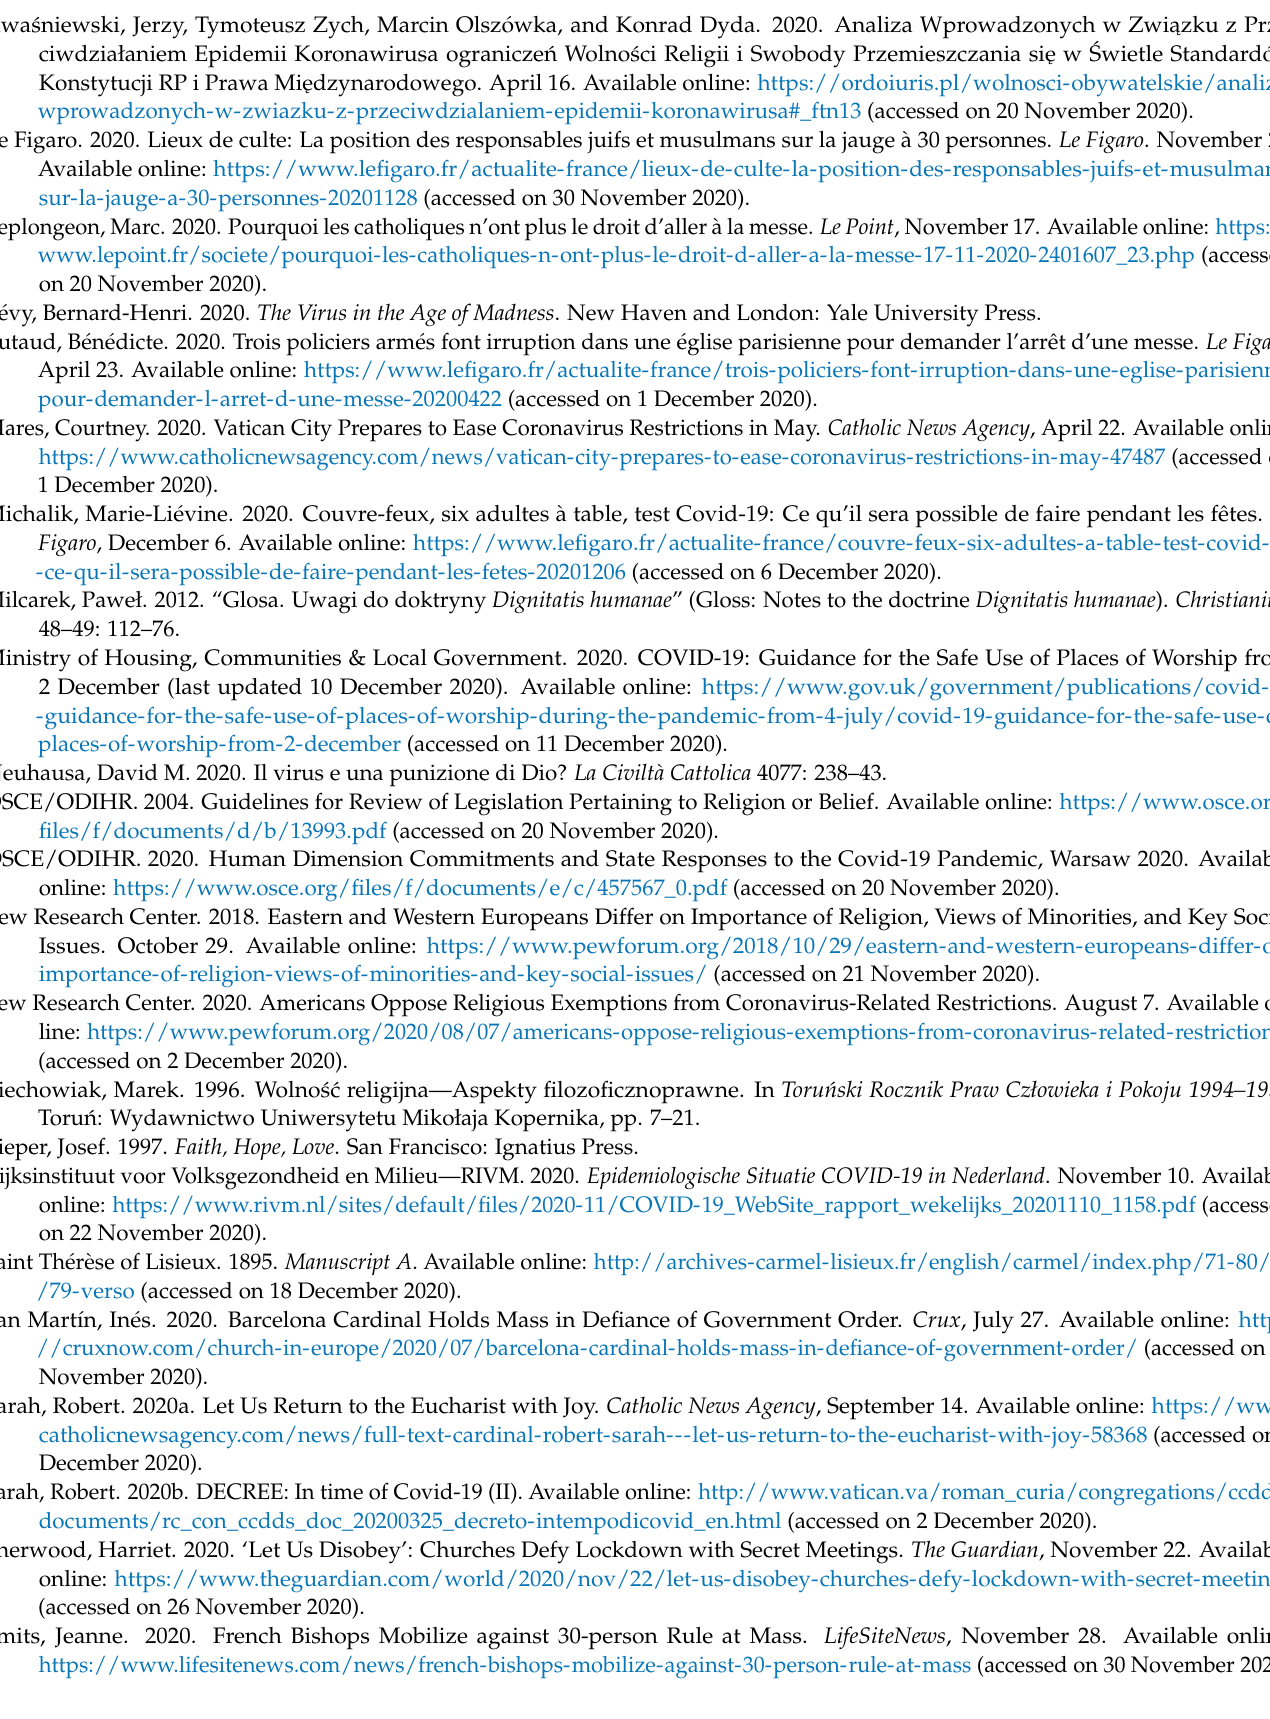
Le Figaro. 2020. Lieux de culte: La position des responsables juifs et musulmans sur la jauge à 30 personnes. Le Figaro . November 28, Available online: https://www.lefigaro.fr/actualite-france/lieux-de-culte-la-position-des-responsables-juifs-et-musulmans-